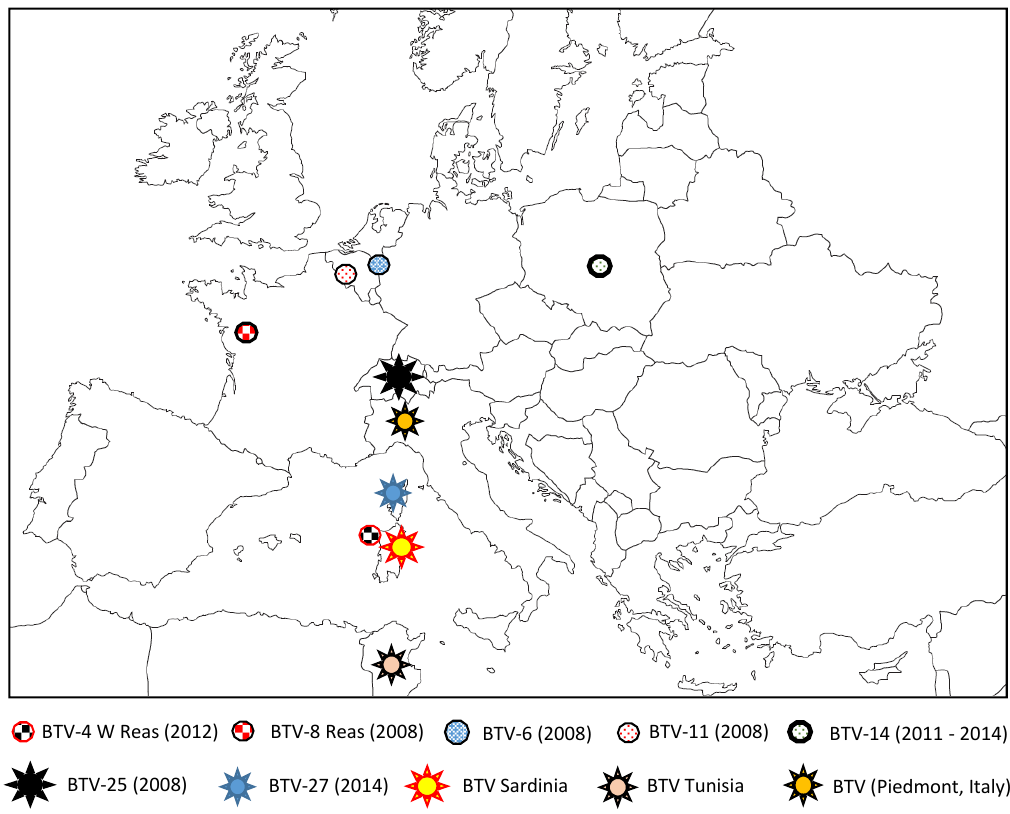
Figure 3. BTV reassortant strains (BTV-4 W Reas and BTV-8 Reas), modified strains (BTV-6, 11 and 14), and novel BTV strains or serotypes detected in Europe (BTV-25, Piedmont) and in the Mediterranean Basin (Sardinia, Corsica, and Tunisia) from 2008 to